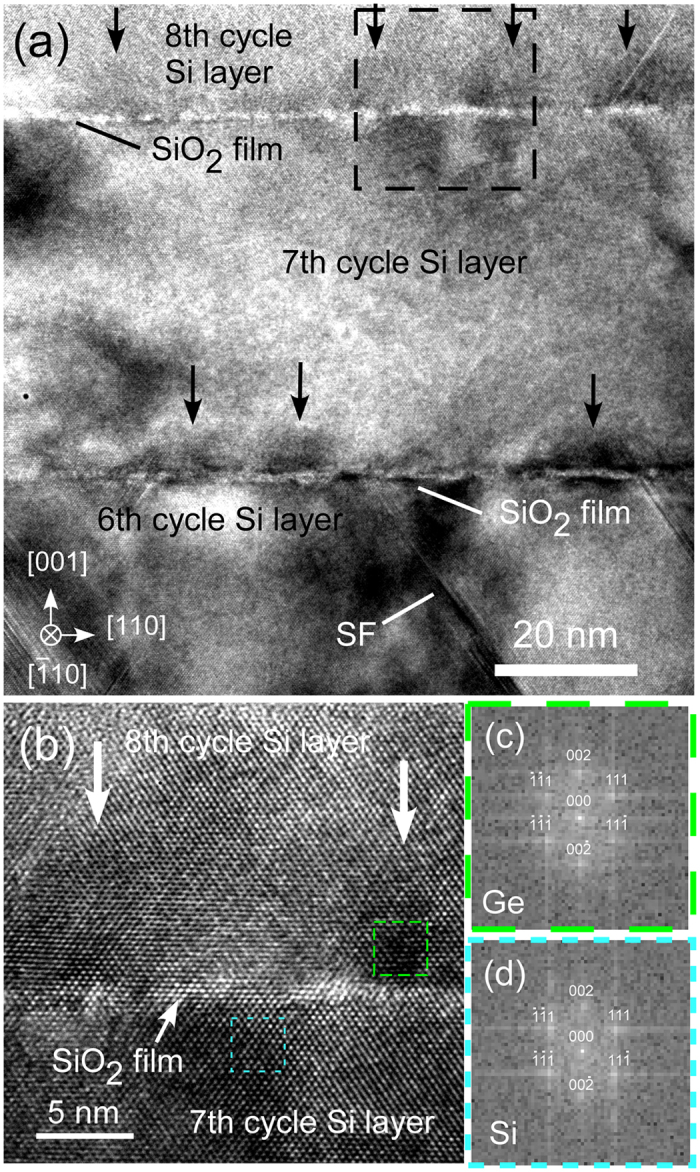
(a) Cross-sectional HRTEM image of the P ion-implanted (110 keV, 4 × 1014 cm−2) stacked structure (8-nm NDs/376-ML Si sample) at higher magnification. The electron beam energy is 200 keV. (b) Enlarged image of the boundary between 8th and 7th cycle Si layers marked by the dashed square in (a). (c,d) FFT patterns of the regions marked by dashed squares in (b).